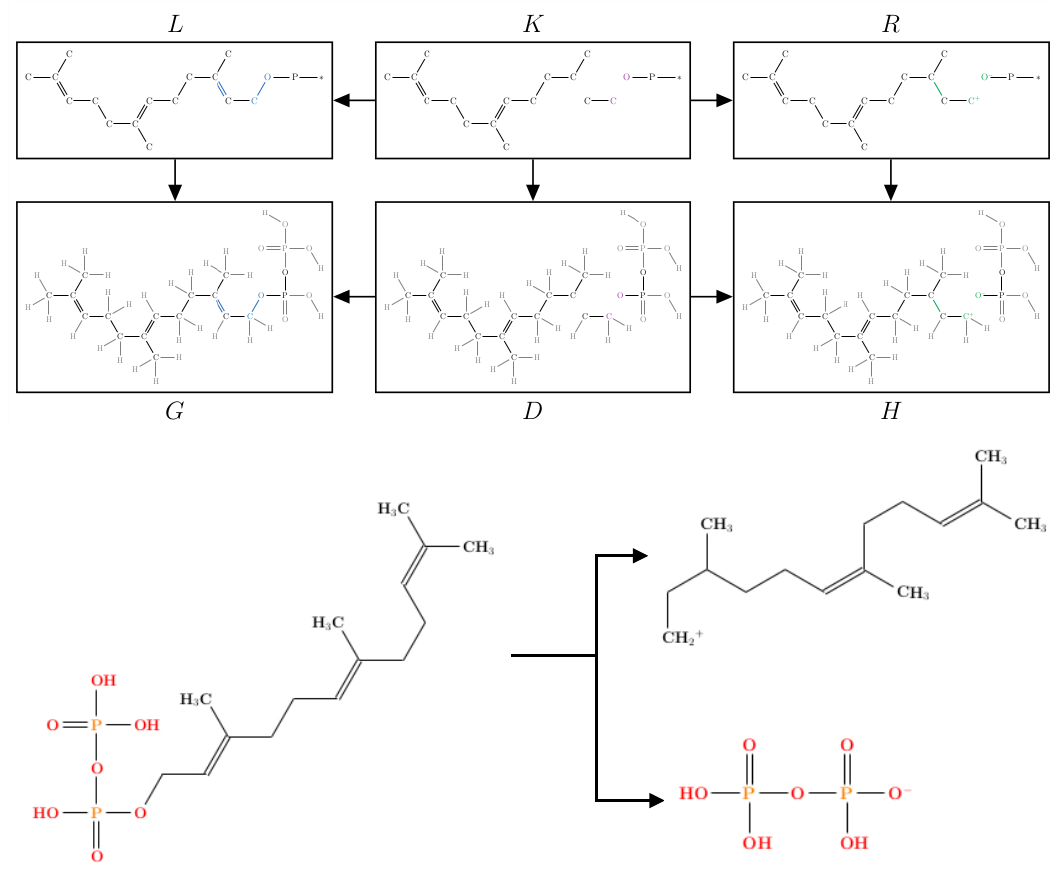
Figure 6. An example of a graph grammar rule for the OPP loss applied to the FPP molecule. The resulting pathway is a directed hypergraph with the reachable